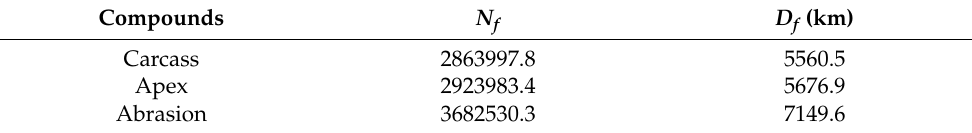
Table 3. Prediction values fatigue life ( N f ) and driving distance ( D f ) for rubber compounds.